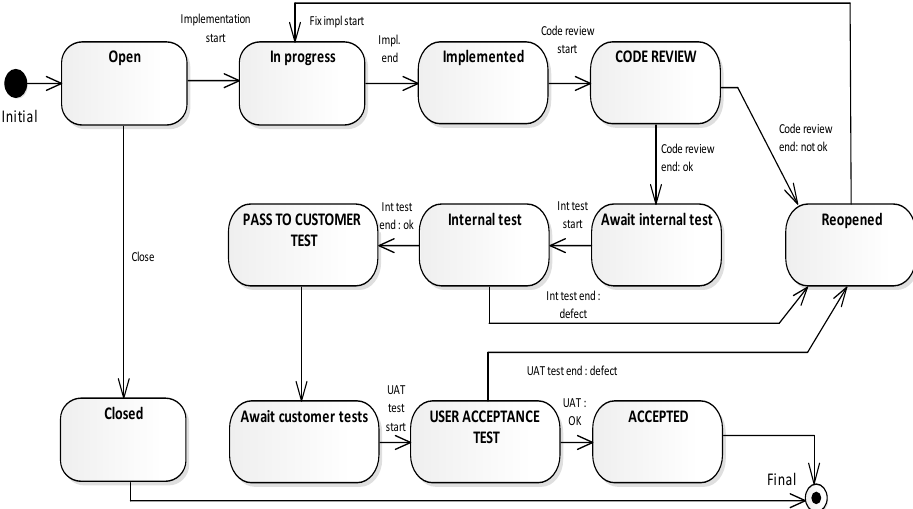
Figure 2. A typical simplified issue workflow used in projects.